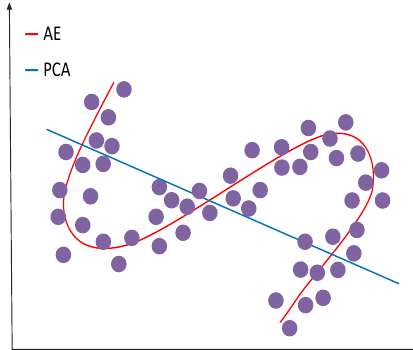
Figure 1. A comparison of linear and nonlinear dimension